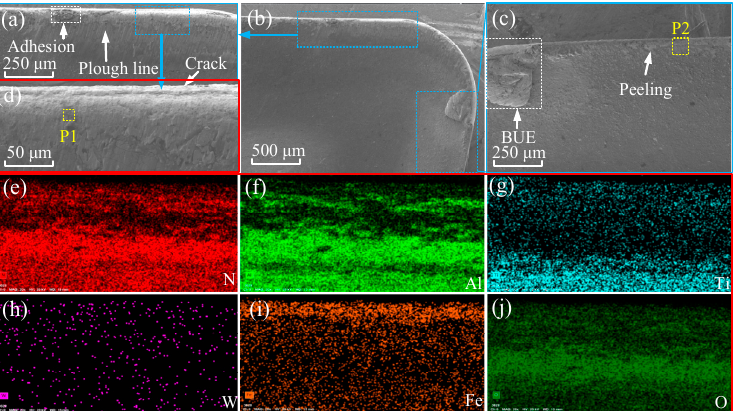
Figure 13. ( a – d ) The rake face wear of Tool A after 16 min of cutting. ( e – j ) Distribution of elements.